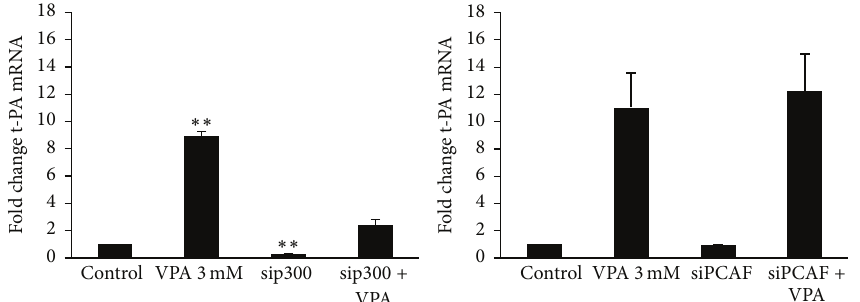
Figure 7: t-PA mRNA expression after siRNA mediated knock-down of p300 and PCAF. HUVECs were treated with p300 or PCAF-targeting siRNAs for 72 h and then stimulated with 3mM VPA for 24 h. Statistical comparisons are made relative to untreated control cells. ∗∗ 𝑝 < 0.01 . The results are presented as mean values ± SEM of three independent experiments. The statistical evaluation was performed using paired Student’s 𝑡 -test together with Bonferroni correction for multiple analysis. Not shown in the illustrations are transfection controls with transfection reagent only (mock) and transfection with “All Star Negative” control siRNA (ASN) that were included in each experiment. These negative controls showed no significant effect on either t-PA or target